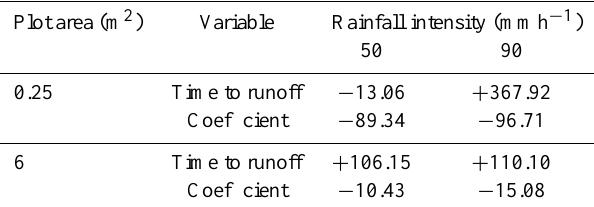
Table 2. Changes (%) in time to runoff and coefficient in plots treated with rice straw